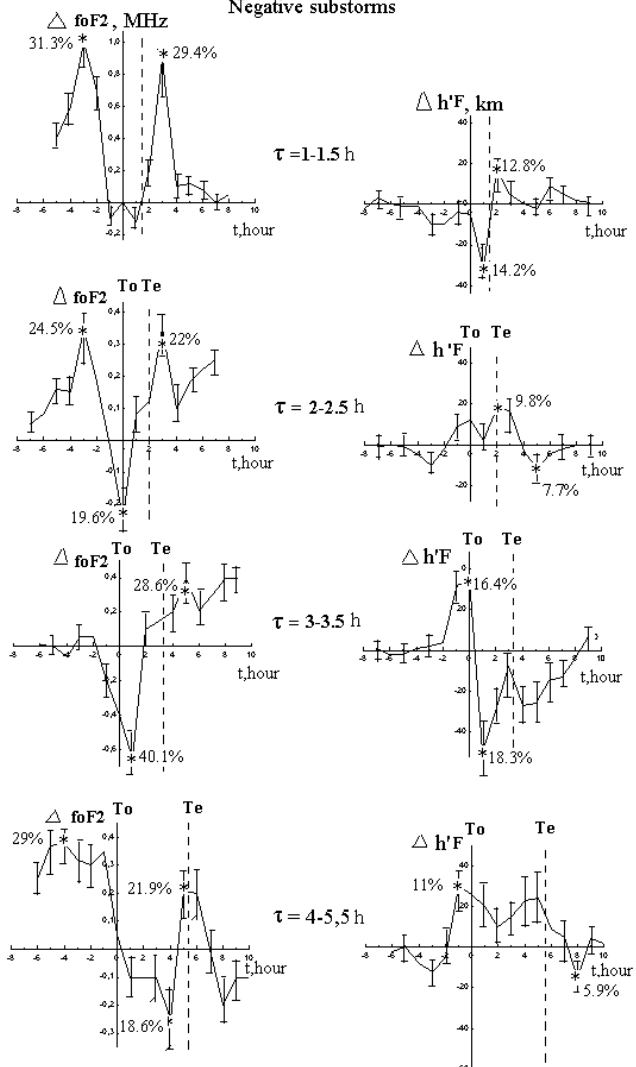
Fig. 1. The average variations of 1 fo F2 and 1h 0 F separated by duration into 4 classes: τ = 1 − 1 . 5h, τ = 2 − 2 . 5h, τ = 3 − 3 . 5h, and τ = 4 − 6h. The vertical lines mark substorm onset, T o , and the average end of the substorm. T e . Asterisks are δ fo F2 (%) and δh 0 F(%)